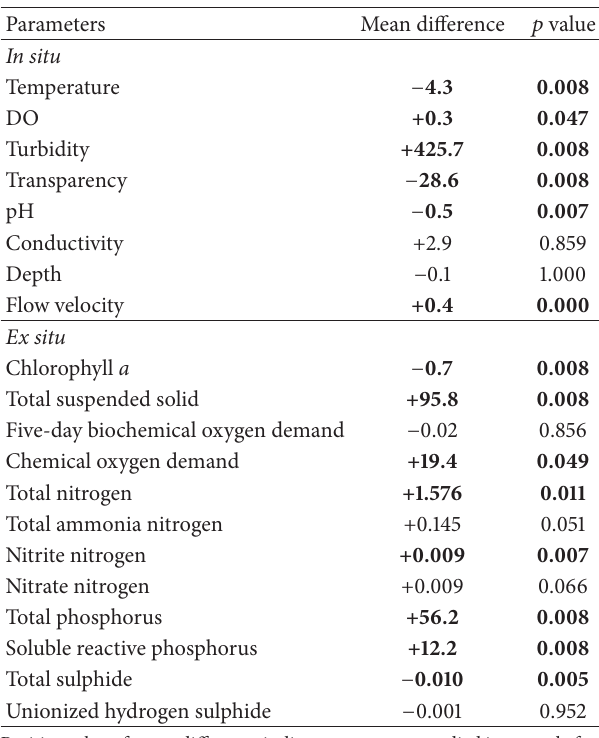
Positive value of mean difference indicates parameter studied increased after rain whereas negative value indicates a decrease after rain. The significant difference at 𝑝 value ≤ 0.05 was indicated in